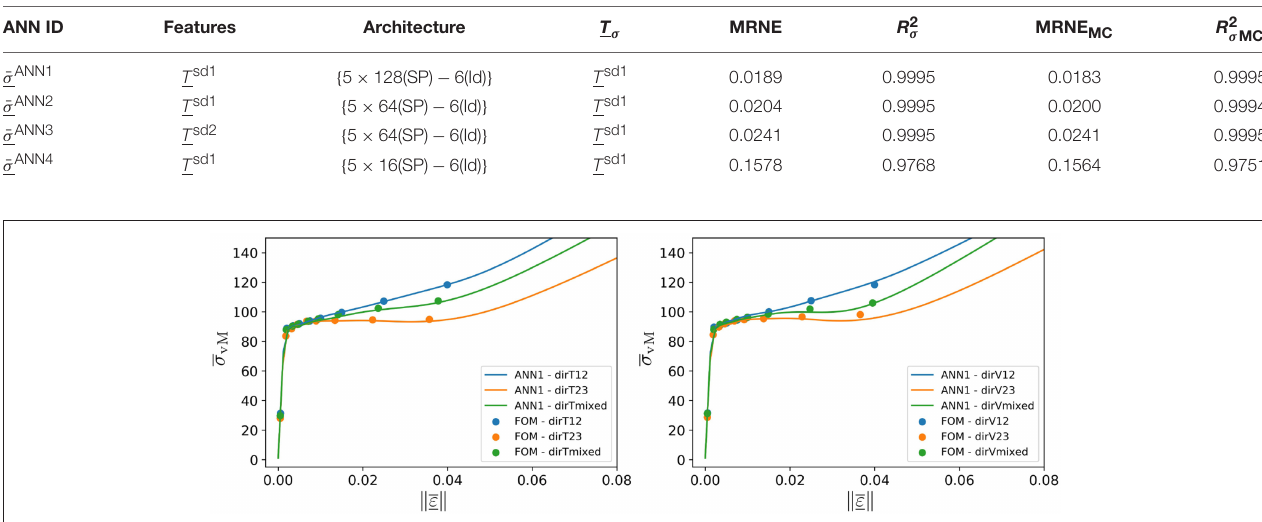
FIGURE 4 | Von Mises effective stress vs. effective strain norm for ANN1 for the 3 loading directions of the training dataset (Left) and 3 loading directions of the validation dataset (Right) tabulated in Table 2 .